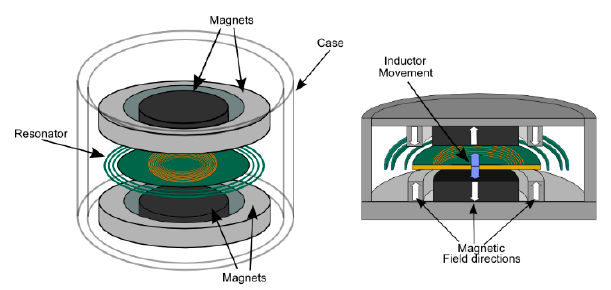
Figure 8. Magnetic kinetic harvester.